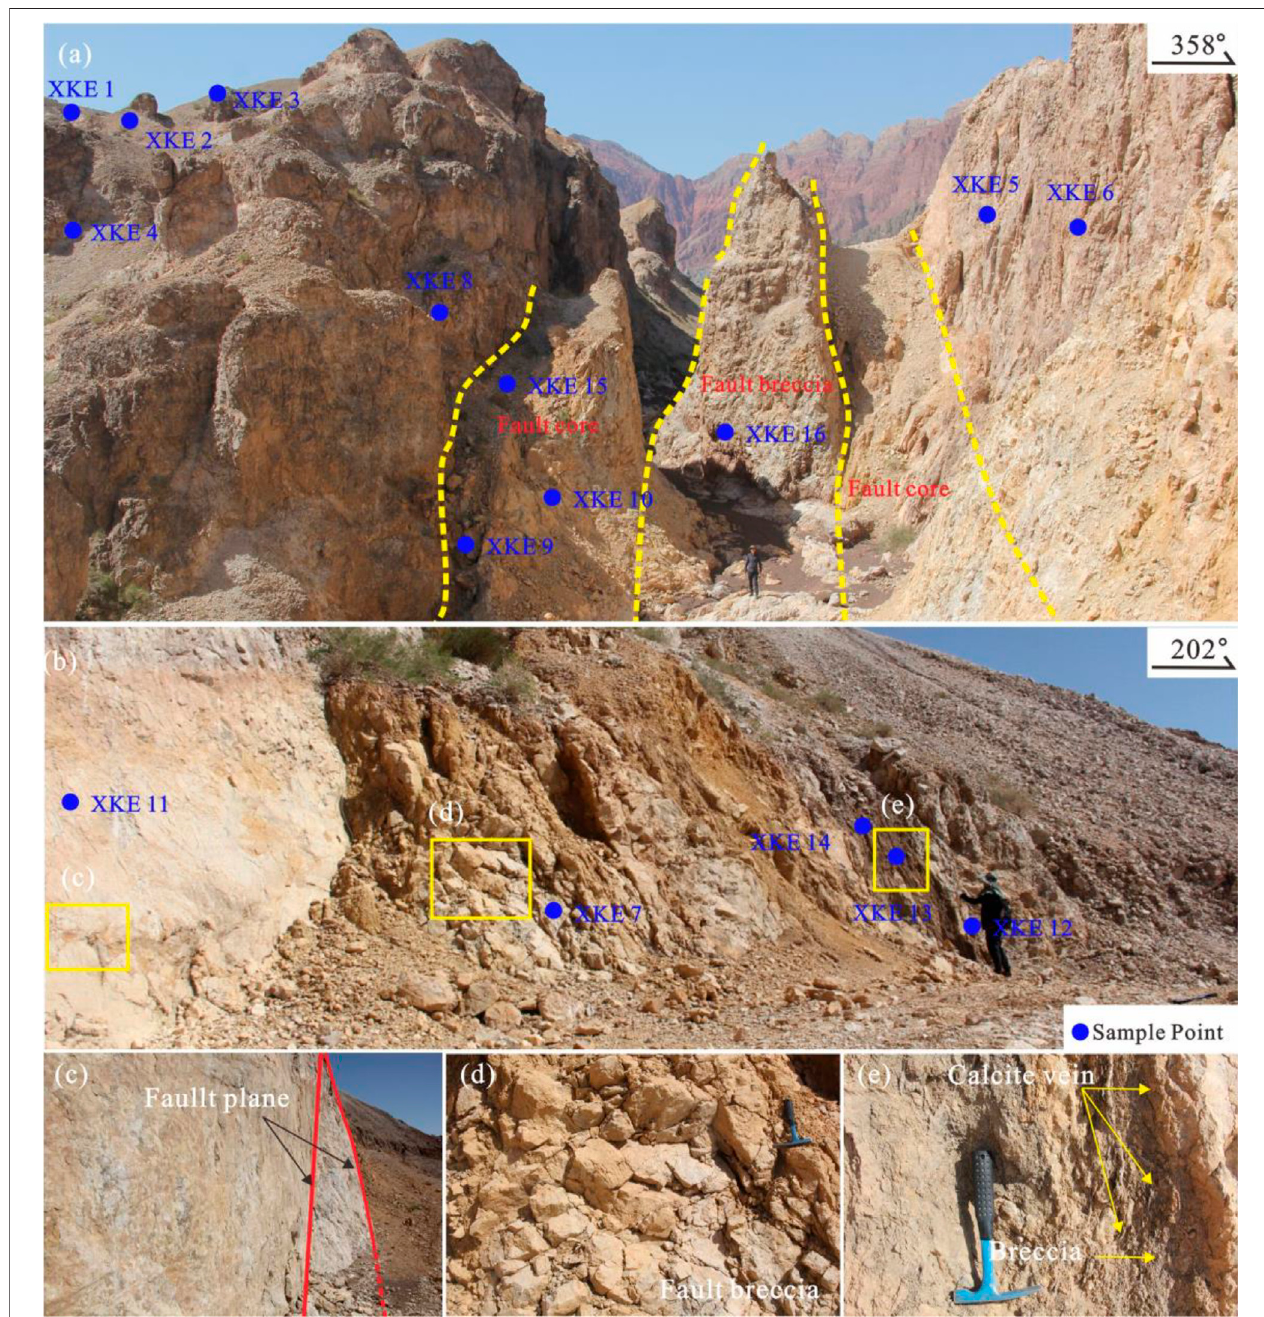
FIGURE3| ThedevelopmentcharacteristicsoftheXike ’ erreversefaultcore. (A) Atotalof16sampleswereselectedfromtheXike ’ erfaultzone,includingfaultcore, damage zone, host rock and overlap zone. The blue dot indicates the position of samples and the dotted line indicates the sliding surface. The morphology of the fault coreisdifferentfromthatofthehostrock. (B) ThefaultcoreoftheXike ’ erfault. (C) Theredlineindicatesaslipplanefault. (D) Faultbreccia ismainlydeveloped inthefault core. (E) The fault core is developed by the fault breccia, calcite veins and fault gouge.